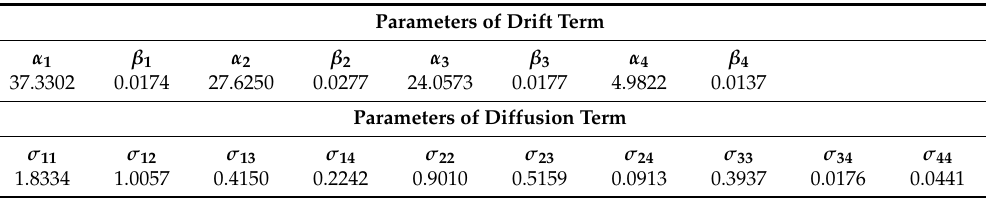
Table 1. Estimates of